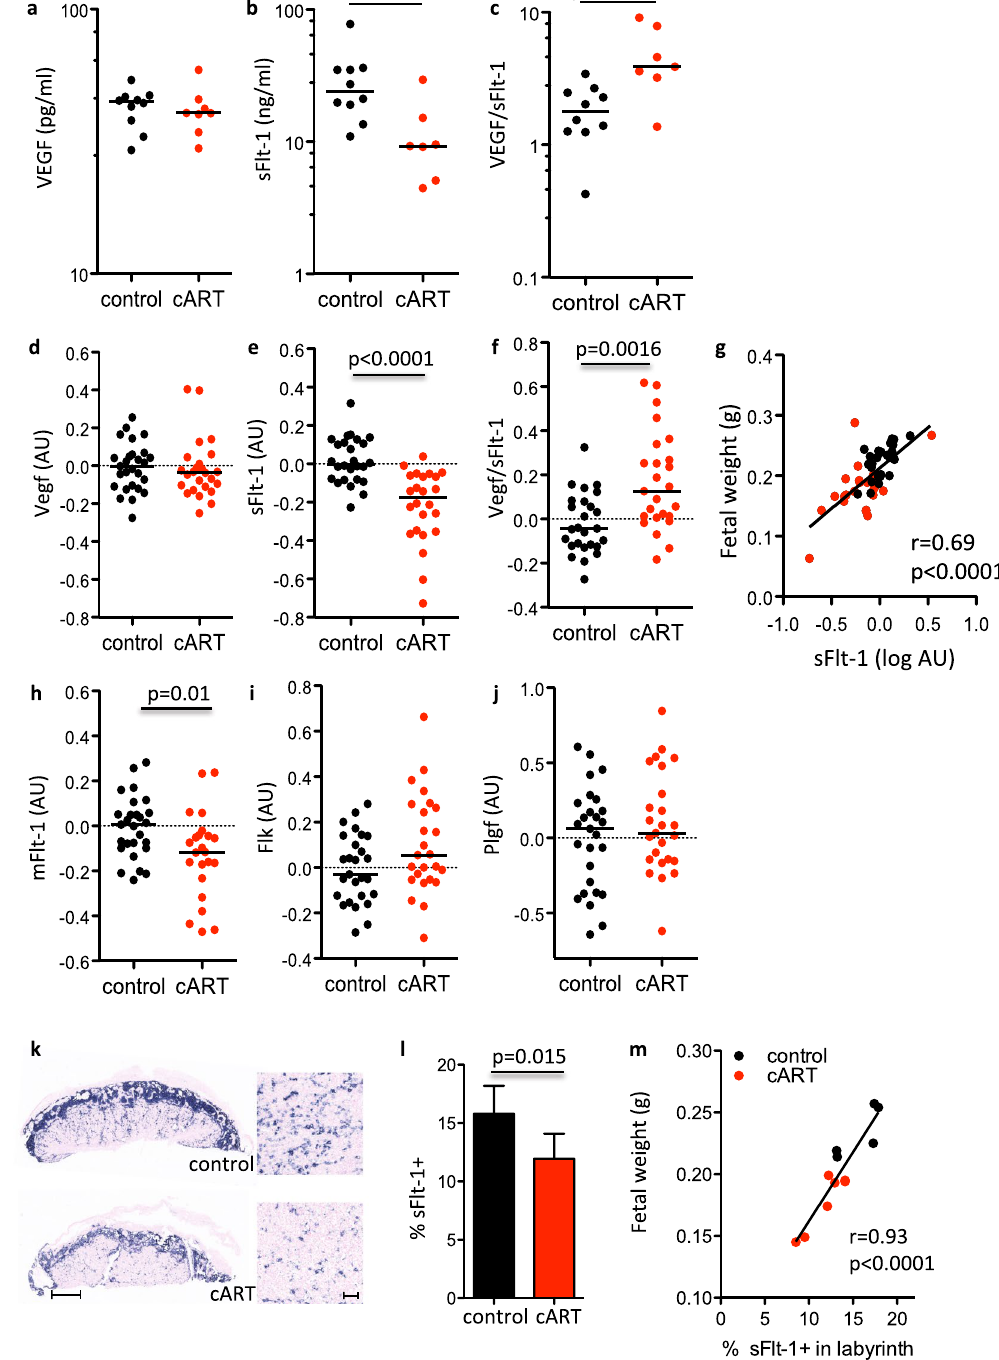
Figure 1. cART exposure during pregnancy is associated with perturbations in the angiogenic balance peripherally and in the placenta. Pregnant mice were treated by gavage with cART (zidovudine/lamivudine/ lopinavir/ritonavir) or water as a control starting on GD1 until sacrifice on GD15. Peripheral levels of VEGF ( a ), sFlt-1 ( b ), and the ratio of VEGF to sFlt-1 ( c ) were assessed by EIA in serum collected at GD15 from control (black) and cART-treated (red) pregnant mice. Placental expression levels of Vegf ( d ), sFlt-1 ( e ), mFlt-1 ( h ), Flk ( i ), and Plgf ( j ) were assessed by qPCR in placentas from control (black) and cART-treated (red) mice collected at GD15. The ratio of placenta levels of Vegf to sFlt-1 is shown in ( f ). A correlation between placenta expression levels of sFlt-1 (log transformed) and fetal weight is shown in ( g ). For ( a–c ) n = 10 control dams and n = 8 cART dams. For ( d–j ) n = 26–27 control placentas from 10 dams and n = 23–26 cART placentas from 8 dams. Data are presented as scatter plots with the horizontal line indicating the median. Statistical significance assessed by Mann-Whitney U test. ( k ) Flt-1 expression (stained blue) in control (top) and cART (bottom) placentas assessed by in situ hybridization. Full placenta sections are shown on the left (scale bar indicates 1 mm). Sections of the labyrinth are shown on the right (scale bar indicates 200 μ m). ( l ) The percentage of Flt-1